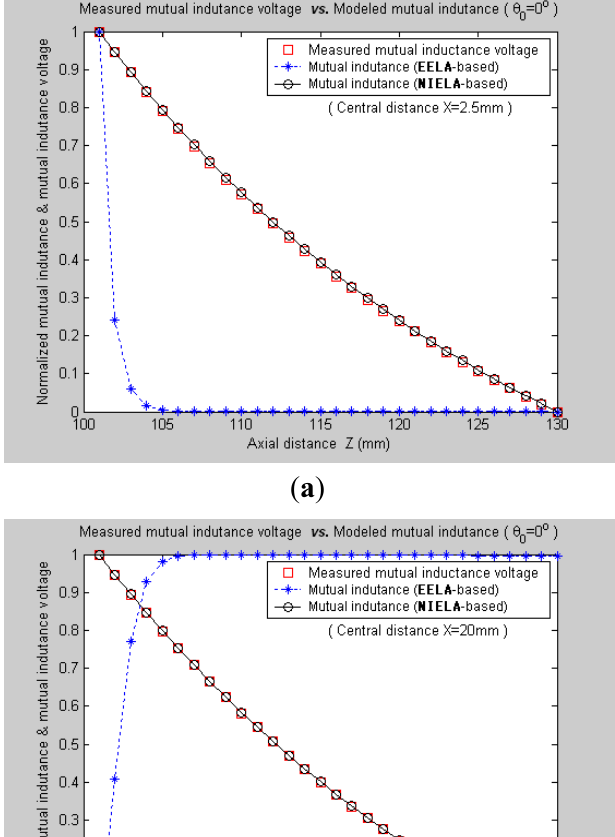
Figure 11. Normalized curves for measured mutual inductance voltage, NIELA -based mutual inductance and EELA -based mutual inductance when θ ( b ) X = 20 mm; ( c ) X = 35